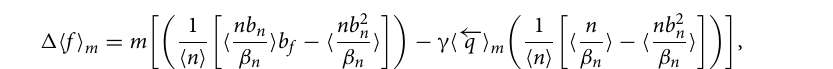
Figure 4. Estimated shifts in extraction patterns due to reallocation dynamics from Nash equilibrium (“Eq”) to steady states (“SS”) under costly extraction: ( a ) Change in total extraction pressure (cid:31) �−→ q , as a function of source degree n ; and ( b ) change in expected agent fitness, �−→ q �−→ q � n = � n ,SS − � n ,Eq (cid:31) f f f as a function of agent degree m . Results shown correspond to a uniform capacity � � m = � � m ,SS − � � m ,Eq β 1 and γ 0.2 scenario with α = = =